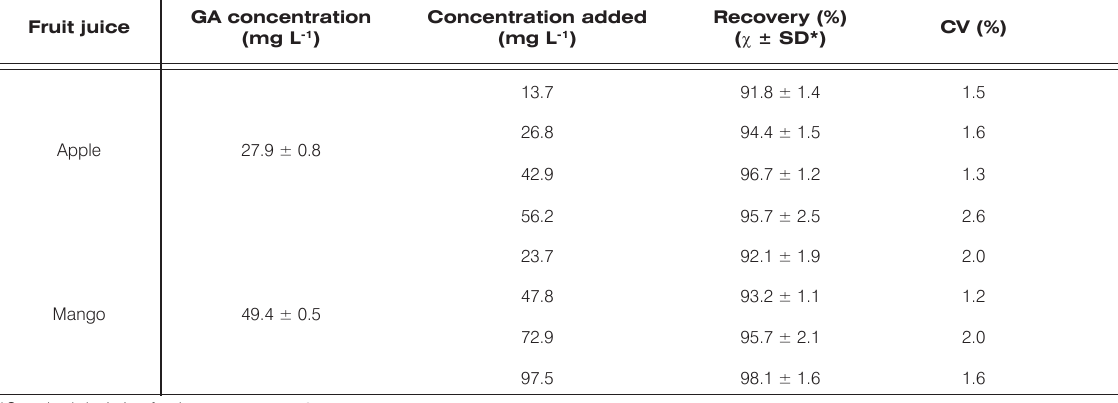
Table 2. Recovery studies using two different fruit juices Fruit